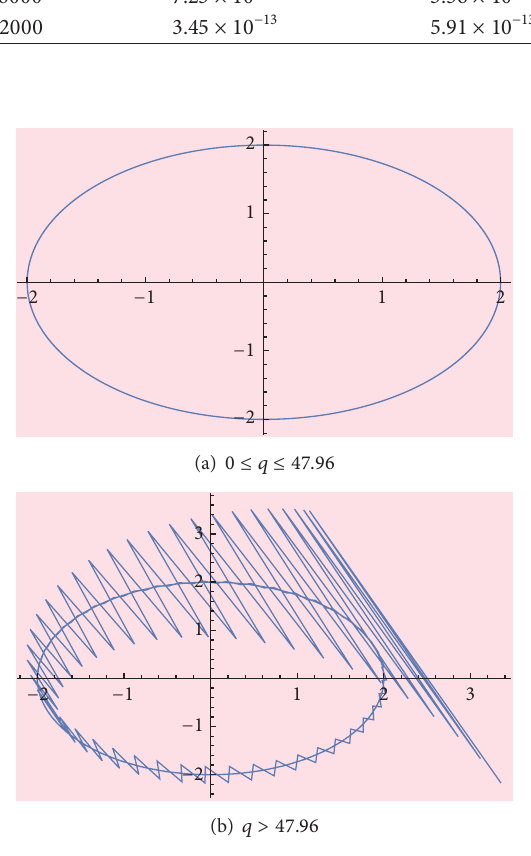
Figure 5: These figures illustrate the stability of the BHTRKNM applied to Example 4. In (a) the method is stable with 𝑁 = 722 , 𝑞 ∈ [0, 47.96] , and the global error is 1.7 × 10 −10 , whereas in (b) the method is unstable with 𝑁 = 721 , 𝑞 > 47.96 , and the global error is